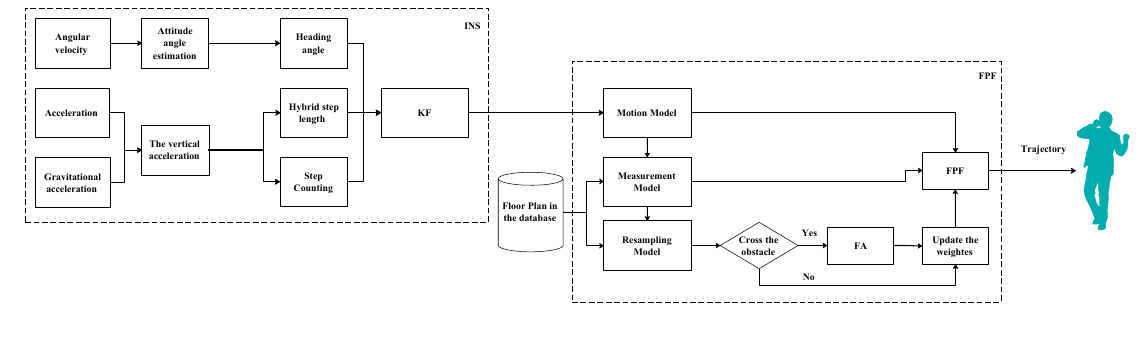
Figure 1. System